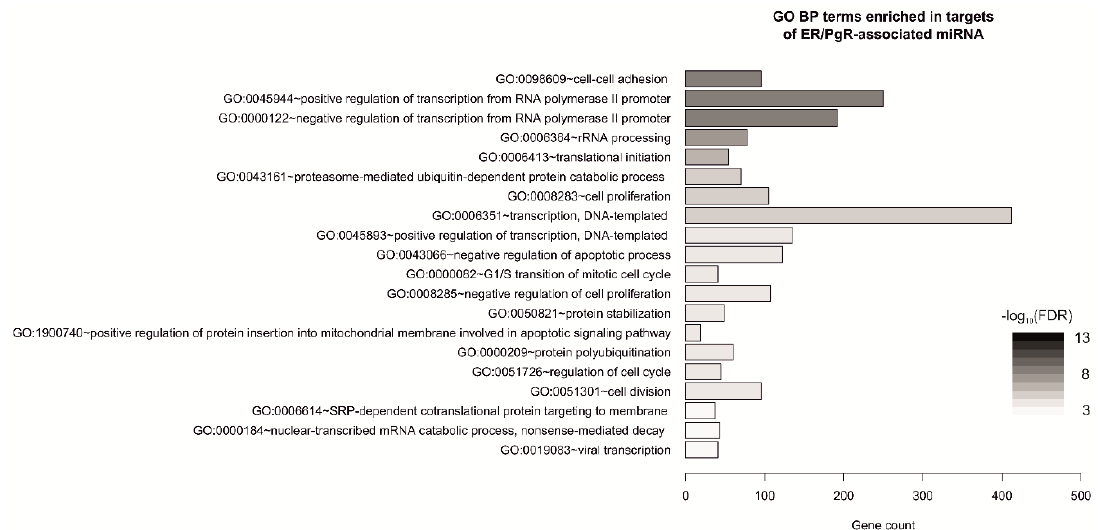
Figure 3. Gene Ontology Biological Process (GO BP) terms enriched in genes targeted by ER/PgR-associated miRNAs in single hormone receptor-positive breast cancers; top20 terms/pathways with the lowest p -value plotted as the number of associated genes (gene count) and ordered according to -log 10(FDR); analyzed with Functional Annotation Tool by DAVID Bioinformatics Resources 6.81.